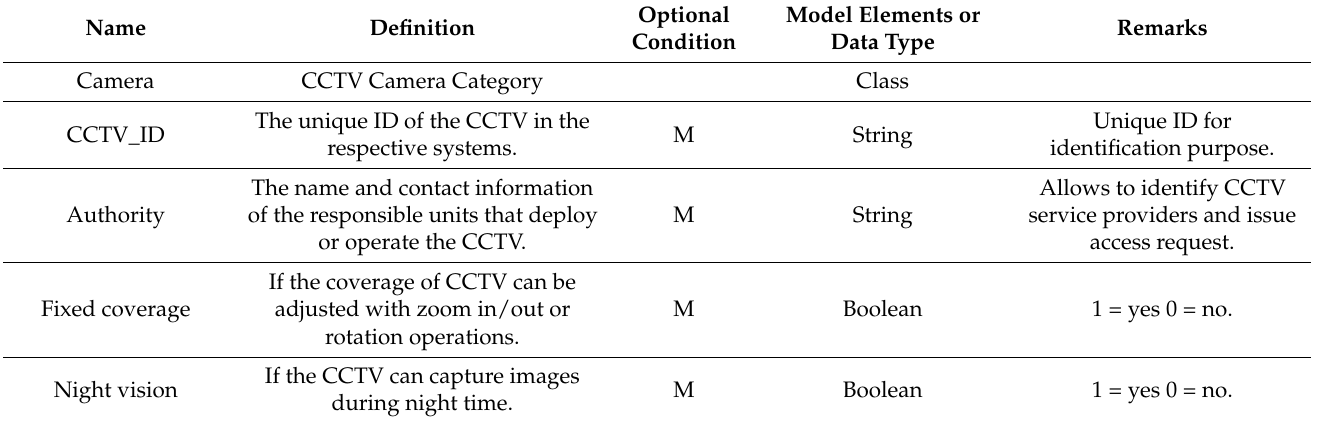
Table 2. Data dictionary of the class of Camera.